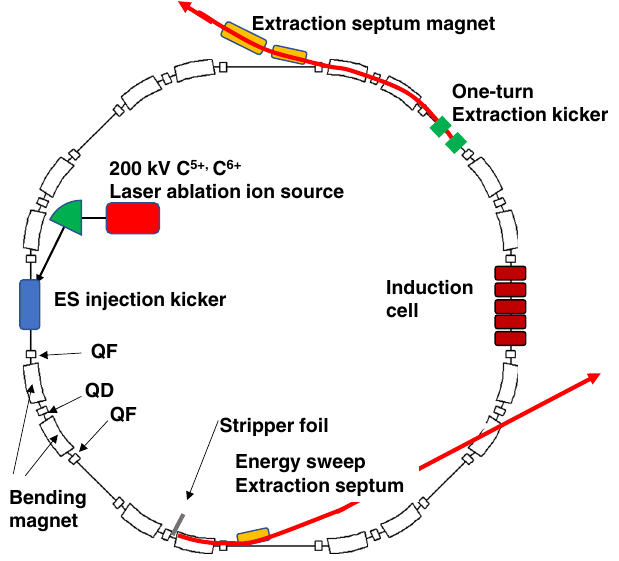
FIG. 1. Lattice of the ESCORT ring.